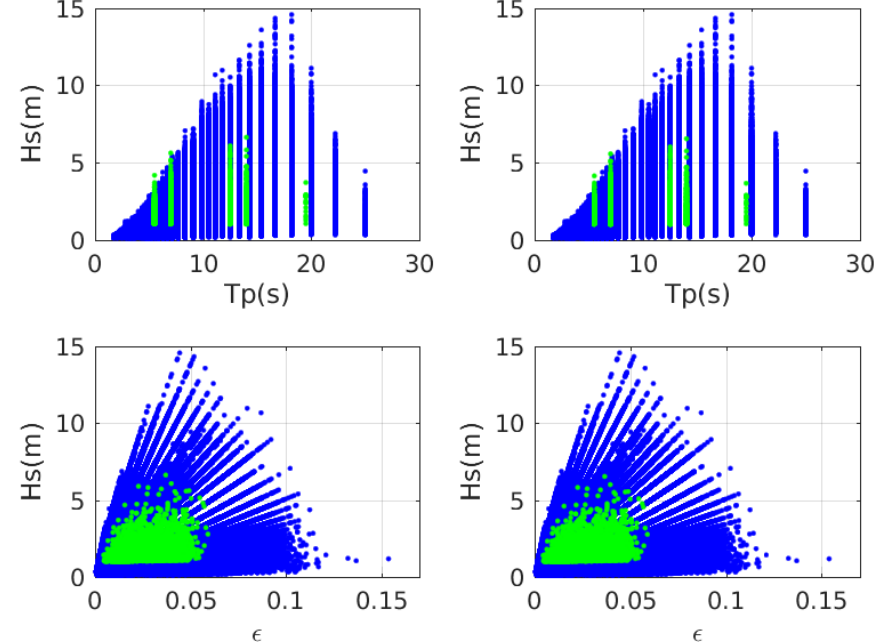
Figure 6. Comparison of H s , T p , and steepness ( ε ) distributions for rogue (green) and non-rogue (blue) datasets. Left panels have rogue statistics computed with rogue events included in each sample. Right panels have rogue statistics computed with rogue events excluded from each sample. J. Mar. Sci. Eng. 2020 , 8 , x